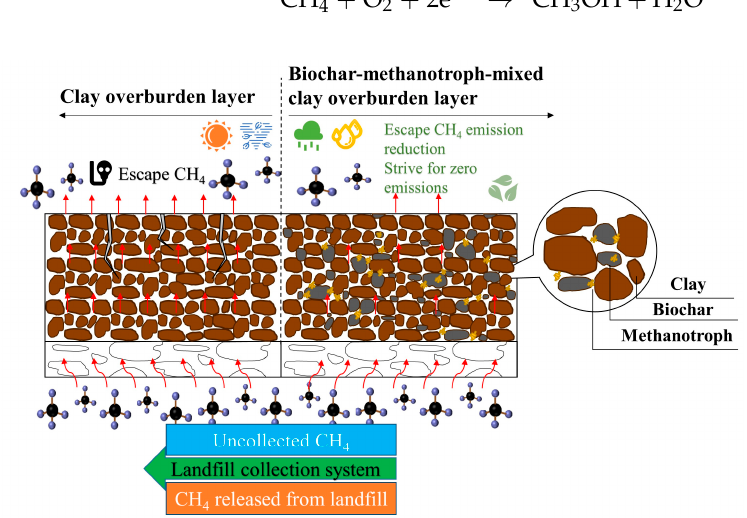
Figure 1. Schematic diagram of biochar–methanotroph–clay covering layer.